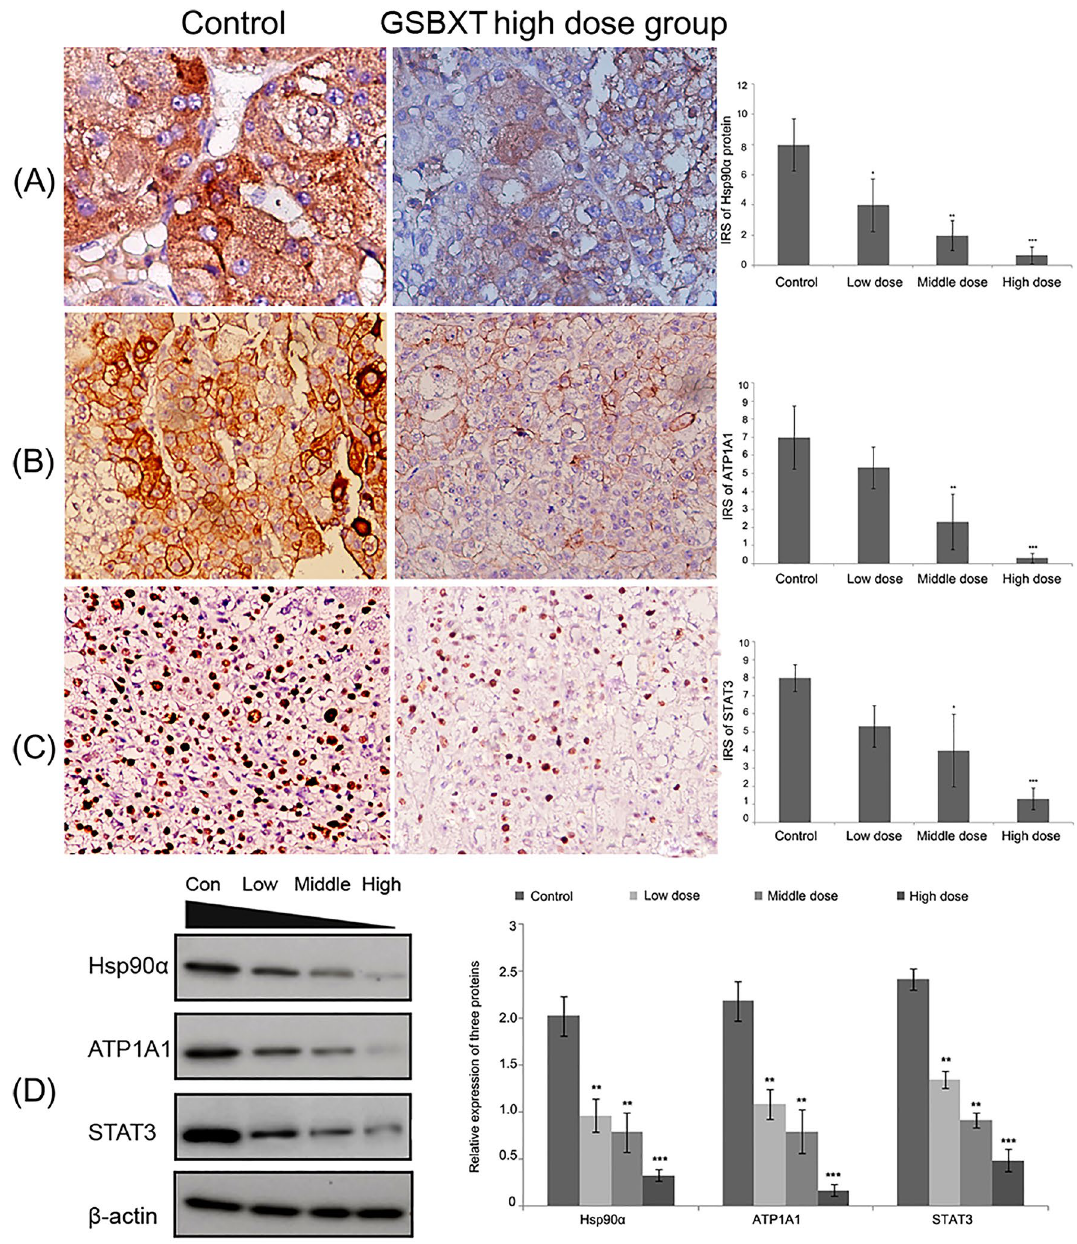
Figure 1. The corrected version of Figure